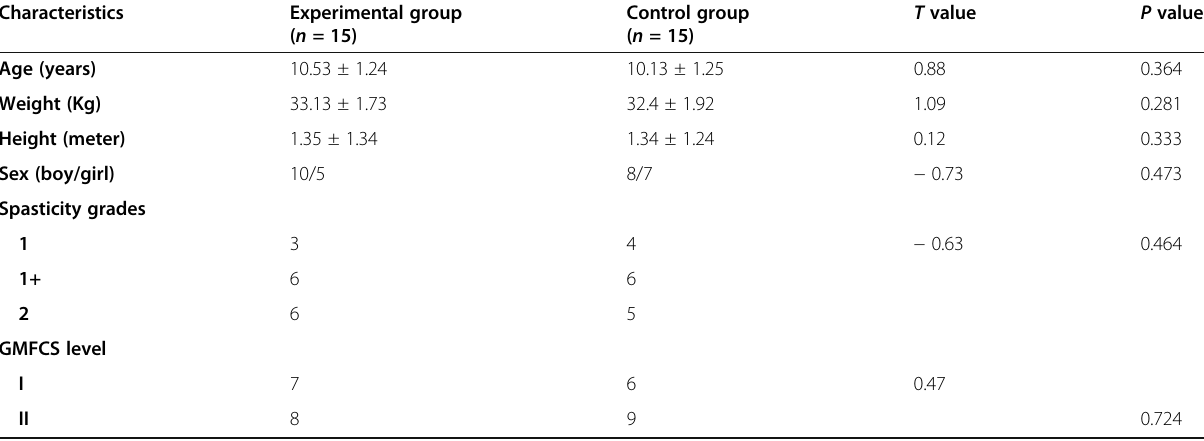
Table 1 Demographical and clinical characteristics of the children at baseline